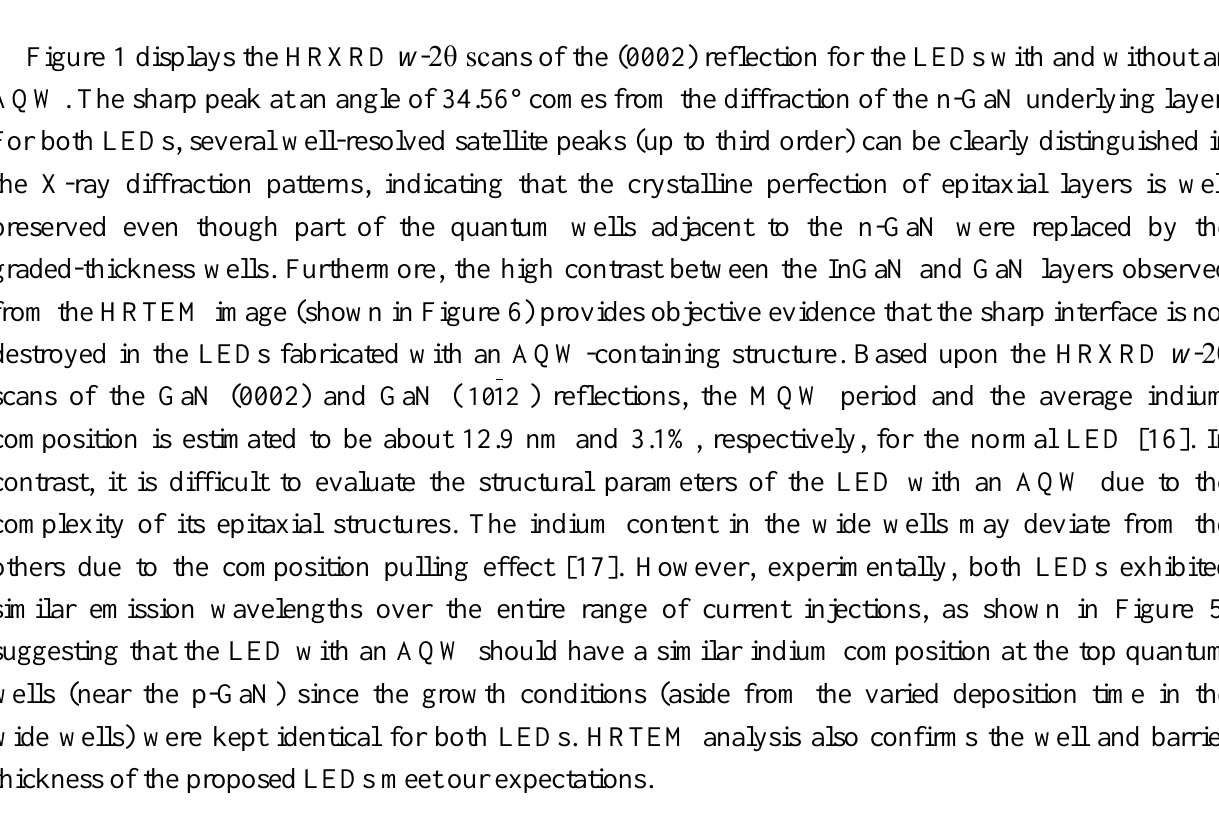
Figure 1. High-resolution X-ray diffraction (HRXRD) w -2θ scans of the (0002) reflections for the LEDs with and without an